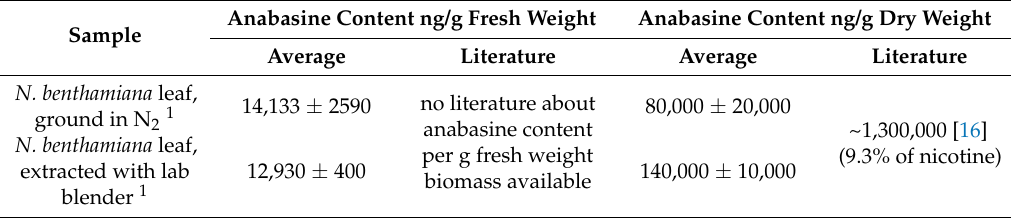
Table 4. Anabasine content of non-treated N. benthamiana. TSP extracts analyzed for alkaloid content by HPLC-MS/MS were prepared with two different extraction methods and the nicotine contents determined were compared to literature.